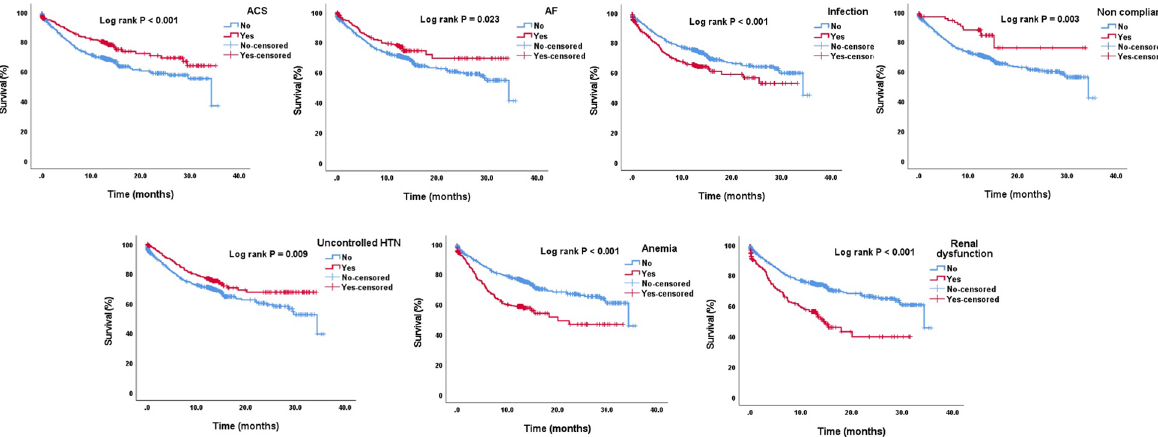
Fig. 1 Overall survival according to different precipitating factors. ACS